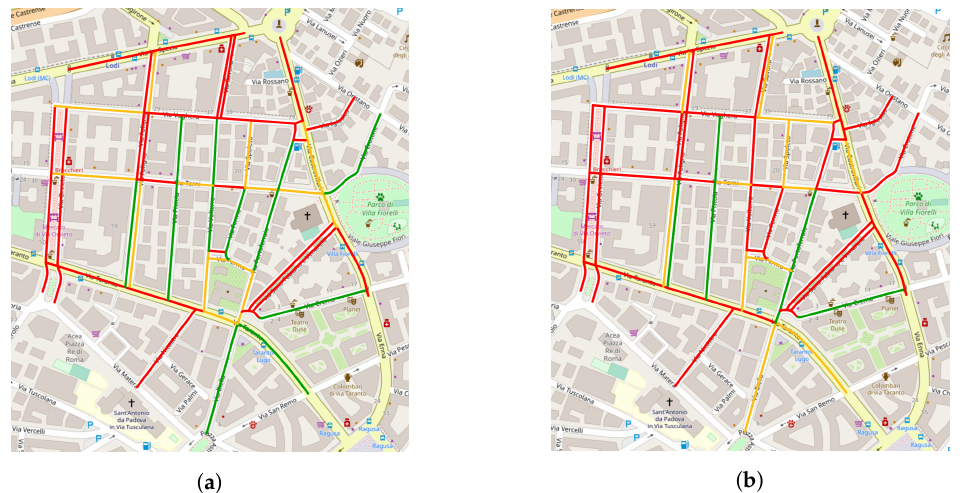
Figure 3. San Giovanni (Rome, Italy) area’s segments. ( a ) Parking availability at 07:00–10:00. ( b ) Park- ing availability at 10:00–13:00.